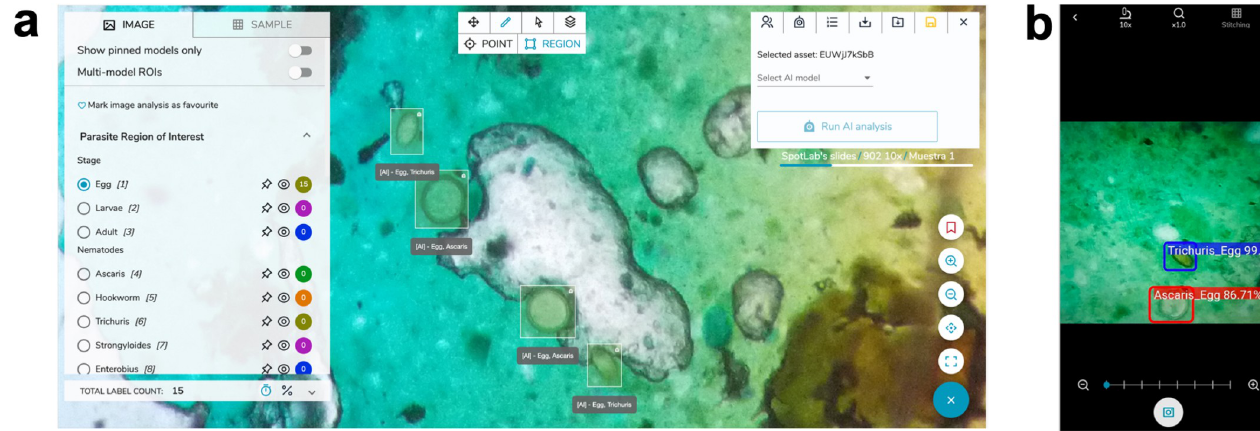
Fig 4. Operational deployment of the AI algorithm on technological platforms. (A) Deployment on the telemedicine platform. (B) Prototype of the deployment on the mobile acquisition app. Note: Both the web platform and the mobile application in Fig 4A and 4B have been developed by the authors.